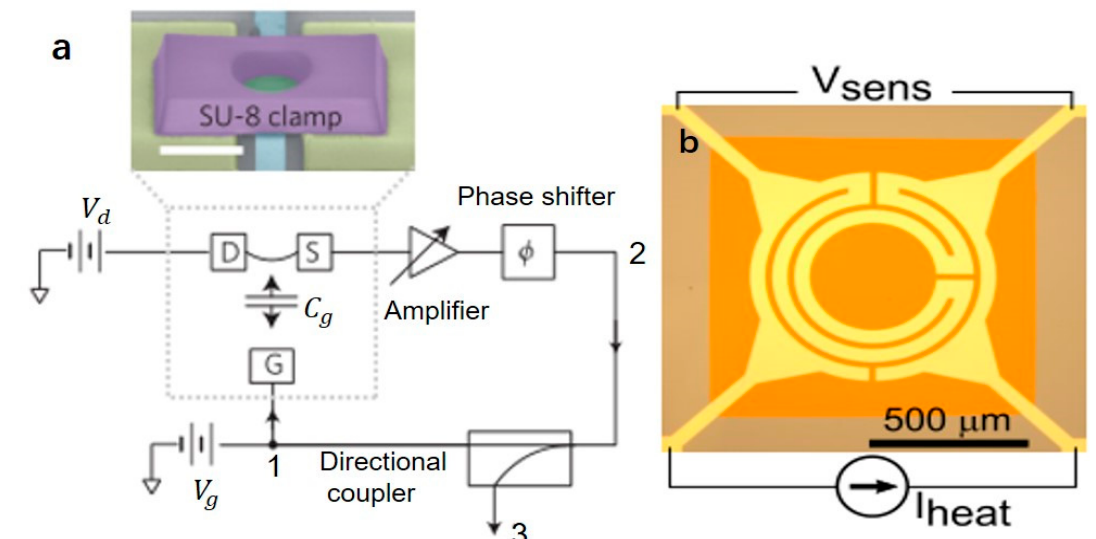
Figure 8. Drum resonator. ( a ) Simplified circuit diagram of graphene oscillator. Inset: false-color SEM image of graphene drum resonator with SU-8 clamp. Adapted with permission from [99]. ( b ) SiN membrane resonator with integrated Pt heaters and schematic of the electrical heating circuit. Adapted with permission from [23].